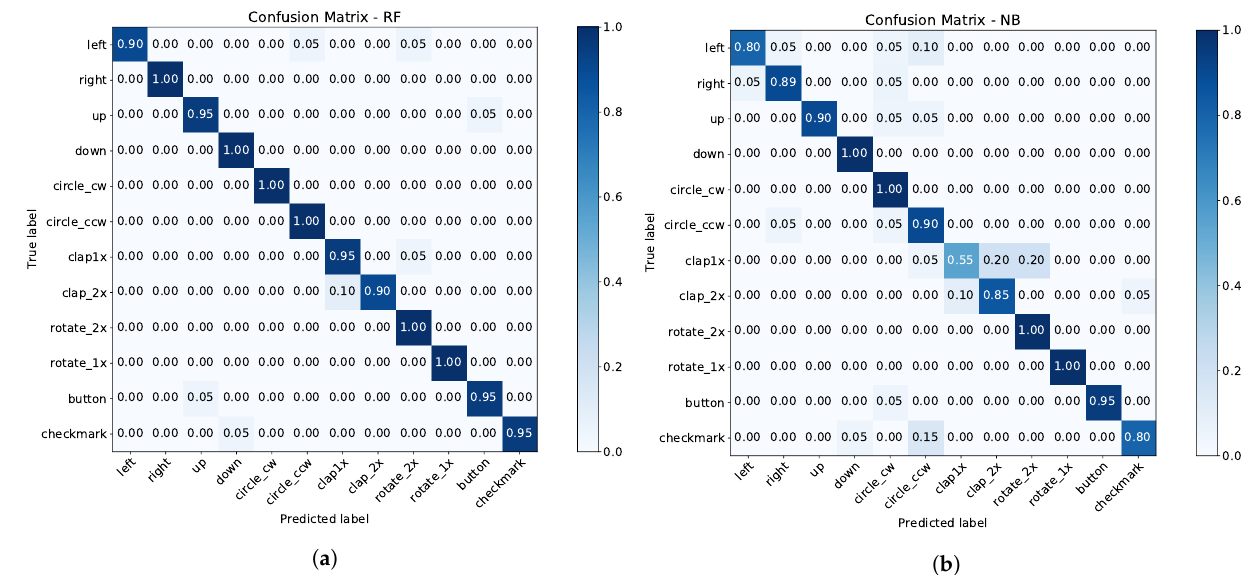
Figure 16. Confusion matrices illustrating results. ( a ) Confusion matrix for the best performing model trained by the ring data set of the watch session. The random forest (RF) model achieved an accuracy of 96.6%, while utilizing the medium sized feature vector. ( b ) Confusion matrix for the worst performing model representative trained by the ring data set of the watch session. The naive Bayes (NB) model achieved an accuracy of 88.6%, while utilizing the medium sized feature